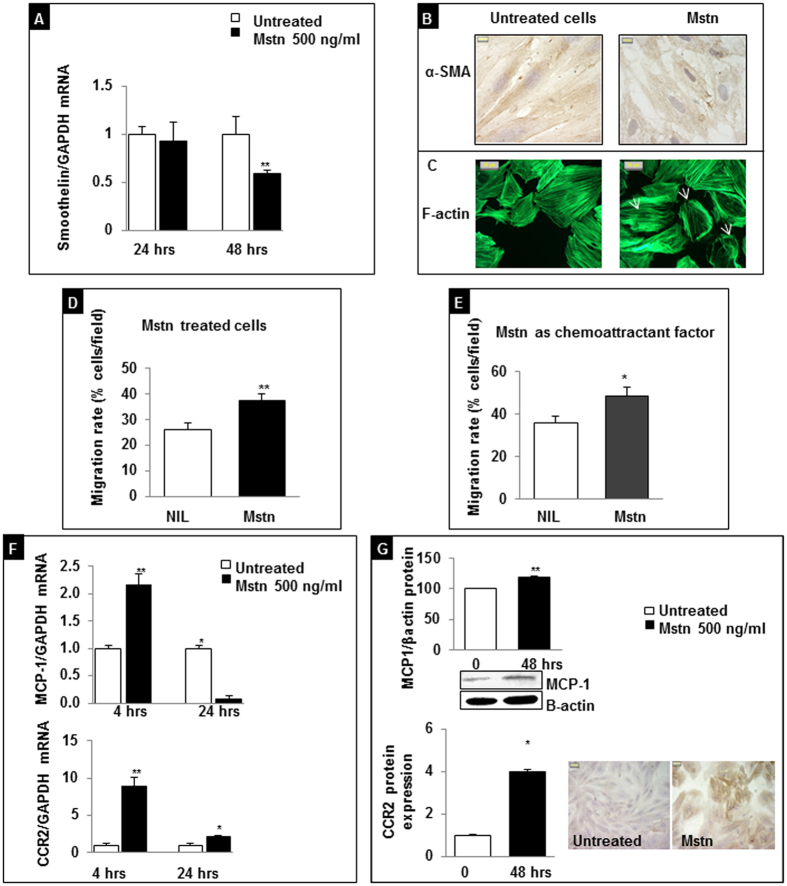
Effects of Myostatin (Mstn) on VSMC phenotype.(A) Smoothelin mRNA expression analyzed by real-time RT-PCR. All data were first normalized to GAPDH mRNA and values were expressed as fold increase ± SEM versus untreated cells. **p = 0.0054. (B) Evaluation of cytoskeleton organization by immunostaining: α smooth muscle actin (α-SMA) network in Mstn treated cells is deranged respect to control cells (magnification 100x). (C) F-actin stress fiber organization visualized with phalloidin-FITC in the absence or presence of Mstn. A 24 hour Mstn treatment affected F-actin organization. Arrows indicate cortical F-actin distribution (magnification 40x). (D) Mstn induces VSMC migration. **p < 0.01 vs. untreated cells. (E) Mstn acts as a chemoattractant stimulus on VSMCs. *p < 0.05 vs. untreated cells. (F) Effects of Mstn on MCP-1 and CCR2 mRNA levels determined by real time PCR after 4 and 24 hour exposition. Values are expressed as fold increase ± SEM versus untreated cells. *p < 0.05, **p < 0.01. (G) MCP-1 and CCR2 protein expression as evaluated by western blot and immunocytochemistry respectively, after a 48 hour treatment.